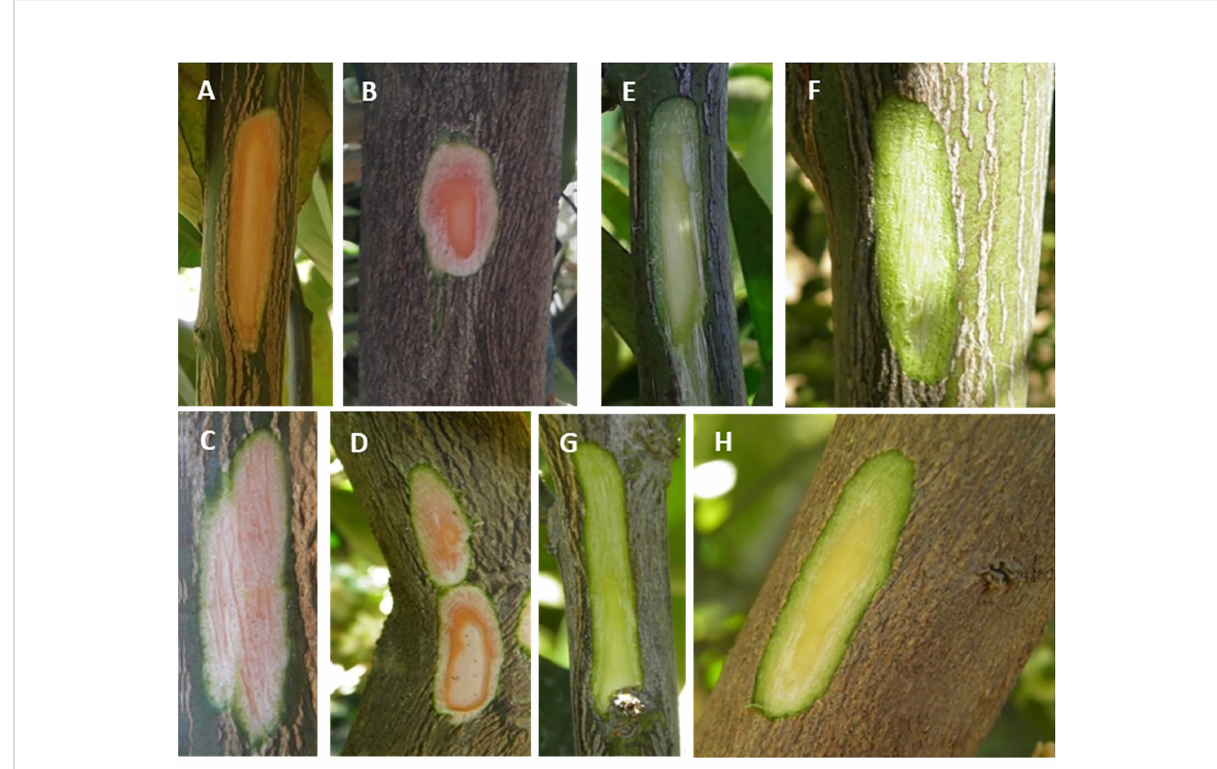
FIGURE 8 Representative pictures of young stems of Kirkwood (A , B) , Ruby (C , D) Navel (E , F) and Valencia (G , H) orange trees grown in South Africa. A small thin layer of the external bark was longitudinally removed to see the colouration of the inner bark and